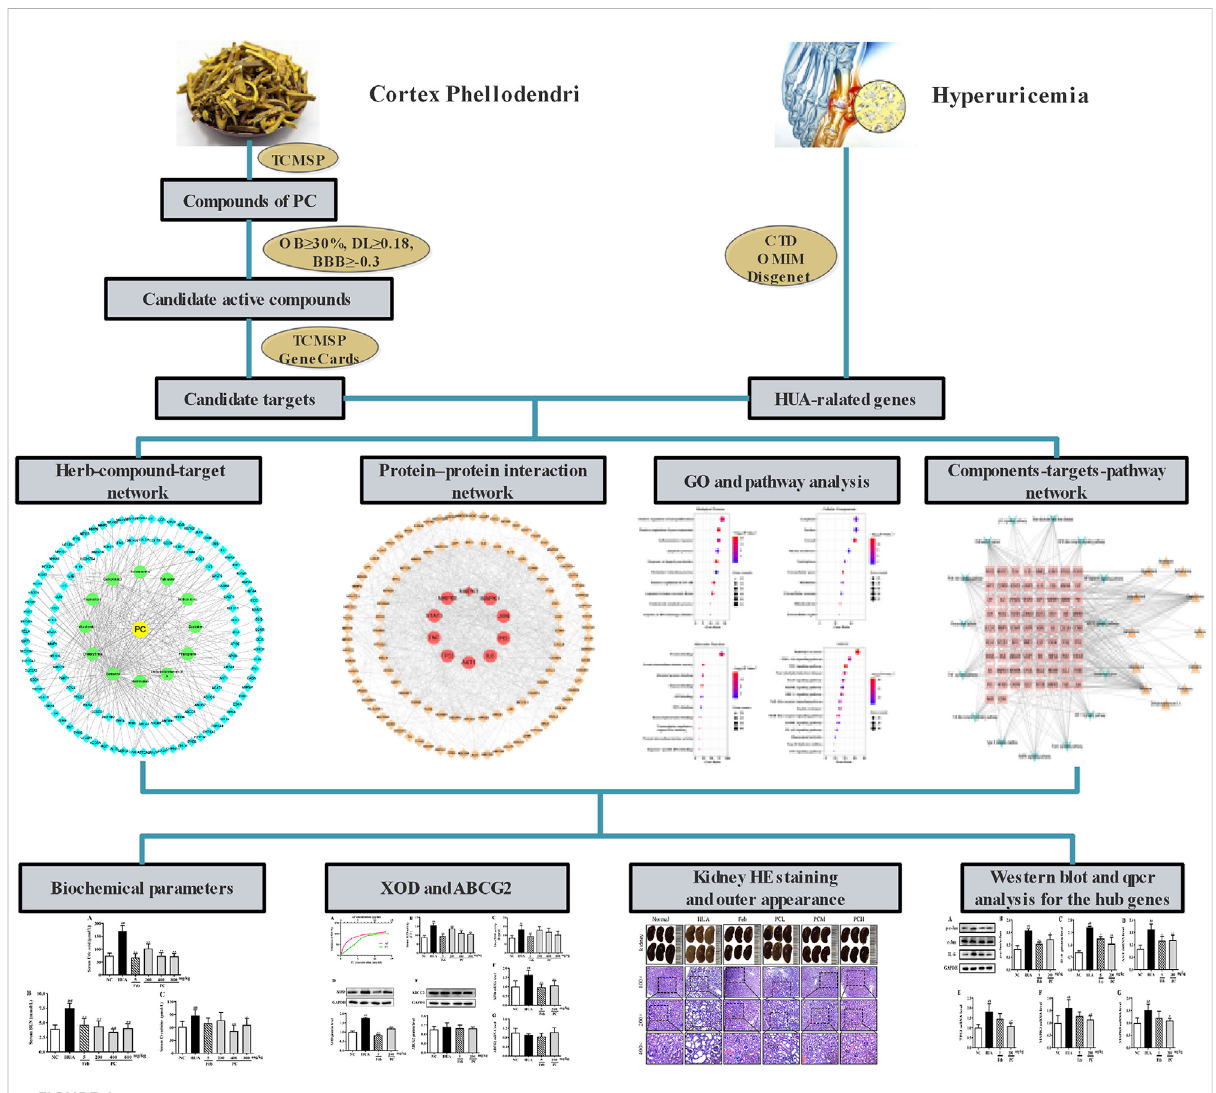
FIGURE 1 The fl owchart of Phellodendri Chinensis Cortex for the treatment of HUA. TCMSP: Traditional Chinese Medicine Systems Pharmacology database; OB: oral bioavailability; DL: drug-like quality; BBB: blood-brain barrier; CTD: Comparative Toxicogenomics Database; OMIM; Online Mendelian Inheritance in